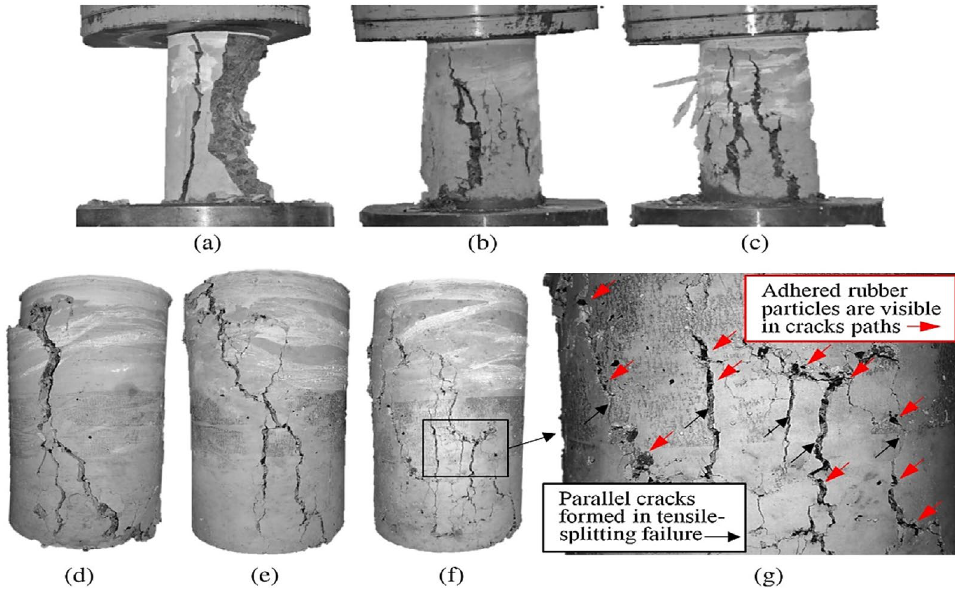
Fig. 27 Effect of CR on concrete cylinders crack pattern ( a ) and ( d ) no rubber, 20% rubber ( b ) and ( e ), 40% rubber in c , f , and g . Data obtained from